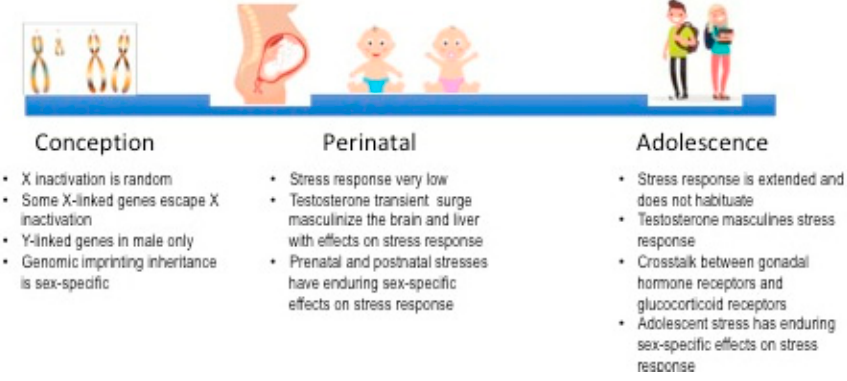
Figure 2. Genetic, organizational, and programming effects involved in sexual dimorphism of glucocorticoid stress response across development.